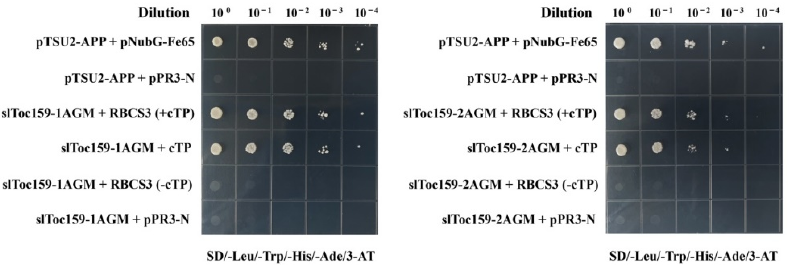
Figure 3. Pairwise yeast two-hybrid interaction studies using slToc159 as bait, with RBCS3 (with or without cTP) as prey. Names in the figure represent the bait protein/construct and the prey protein/construct, respectively. RBCS3(+cTP) represents full-length structures containing transport peptides as prey protein; RBCS3(-cTP) represents truncated structures that do not contain postal transport peptides as prey protein. pTSU2-APP and pNubG-Fe65 as positive controls; pTSU2-APP and pPR3-N as negative controls (Dual systems Biotech). Before photography, the bacterial solution was spot-connected on a petri dish and incubated at 30 °C for 3 days (SD-LWHA/3-AT).